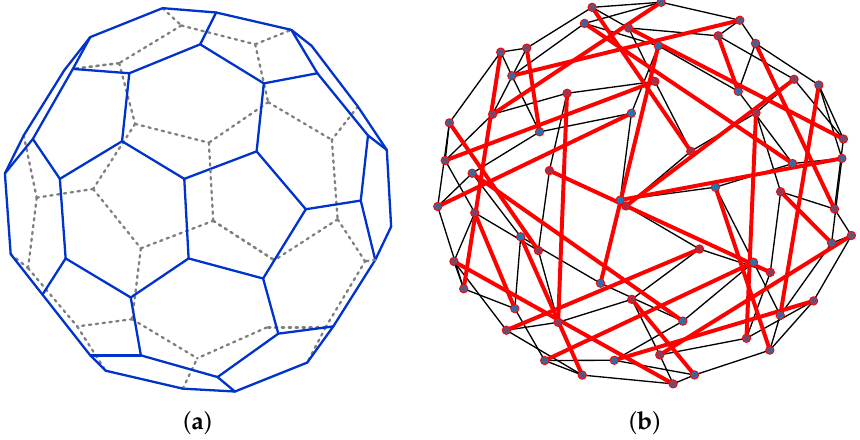
Figure 16. 3D-truncated icosahedron tensegrity in which the red thick lines denote strut members, and others are cable members. ( a ) Geometry. ( b ) Isometric view.